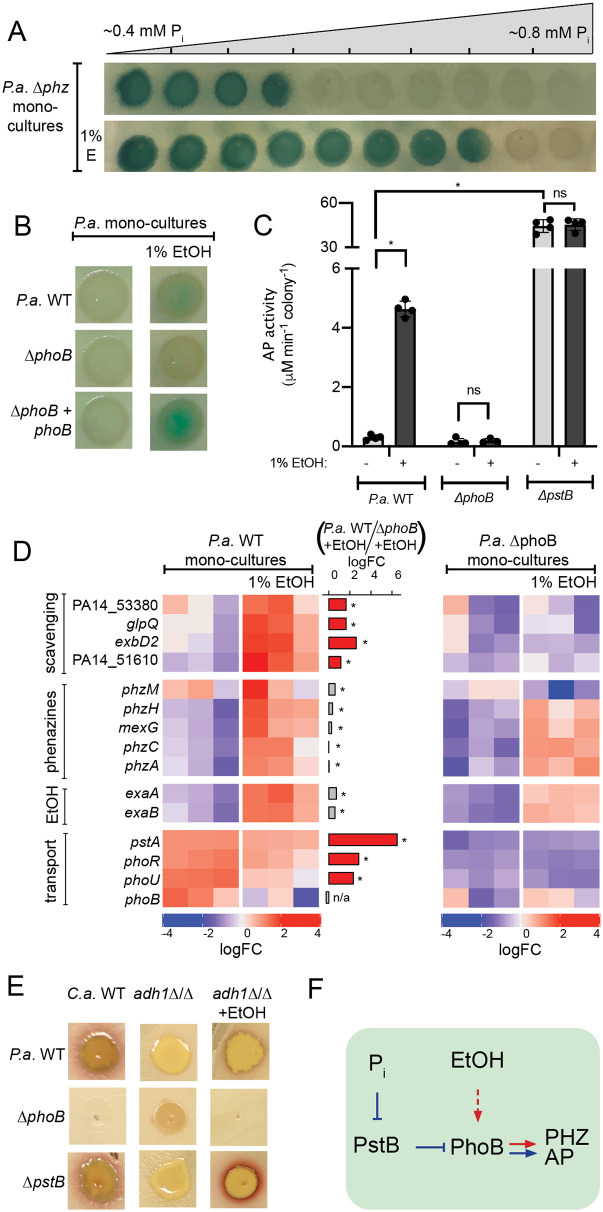
Ethanol (EtOH) induced PhoB activity in P. aeruginosa (P.a.) mono-culture.A) Alkaline phosphatase (AP) activity visualized by blue color derived from cleavage of BCIP in MOPS medium,0.2% glucose, with a gradient of phosphate (Pi) in the absence and presence of ethanol. The P.a. ΔphzA1-G1/A2-G2 strain was used to eliminate color differences due to phenazine production. B) AP activity in the absence and presence of 1% ethanol (E or EtOH) at 0.7 mM Pi for P.a. wild type, ΔphoB and the ΔphoB mutant complemented with a wild-type copy of phoB integrated at the native locus. C) AP activity in cells from colony biofilms grown as in B was measured using the colorimetric substrate pNPP for P.a. WT, ΔphoB, and ΔpstB. *,p<0.01 by ANOVA with Tukey’s multiple comparison test (n ≥ 3). D) Transcripts within the PhoB regulon involved in Pi scavenging and transport and genes involved in phenazine production and EtOH catabolism in P.a. WT and ΔphoB cells grown in the absence and presence of EtOH by Nanostring (codeset PAV5). Expression values normalized to loading controls and housekeeping genes, z-score scaled by gene. Middle bar plot shows log2 fold-change (logFC) between P.a. WT and P.a. ΔphoB on MOPS+1%EtOH. The bar is colored red if expression is PhoB-dependent (logFC P.a. WT / P.a. ΔphoB > 1, FDR < 0.05) else grey. *,FDR < 0.05, #,FDR > 0.05. E) P.a. WT, ΔphoB and ΔpstB grown on C.a. WT, or C.a. adh1Δ/Δ in the absence or presence of 1% exogenous EtOH. F) Pi and EtOH are additive stimuli that promote PhoB-dependent expression of AP and phenazine biosynthesis (PHZ).